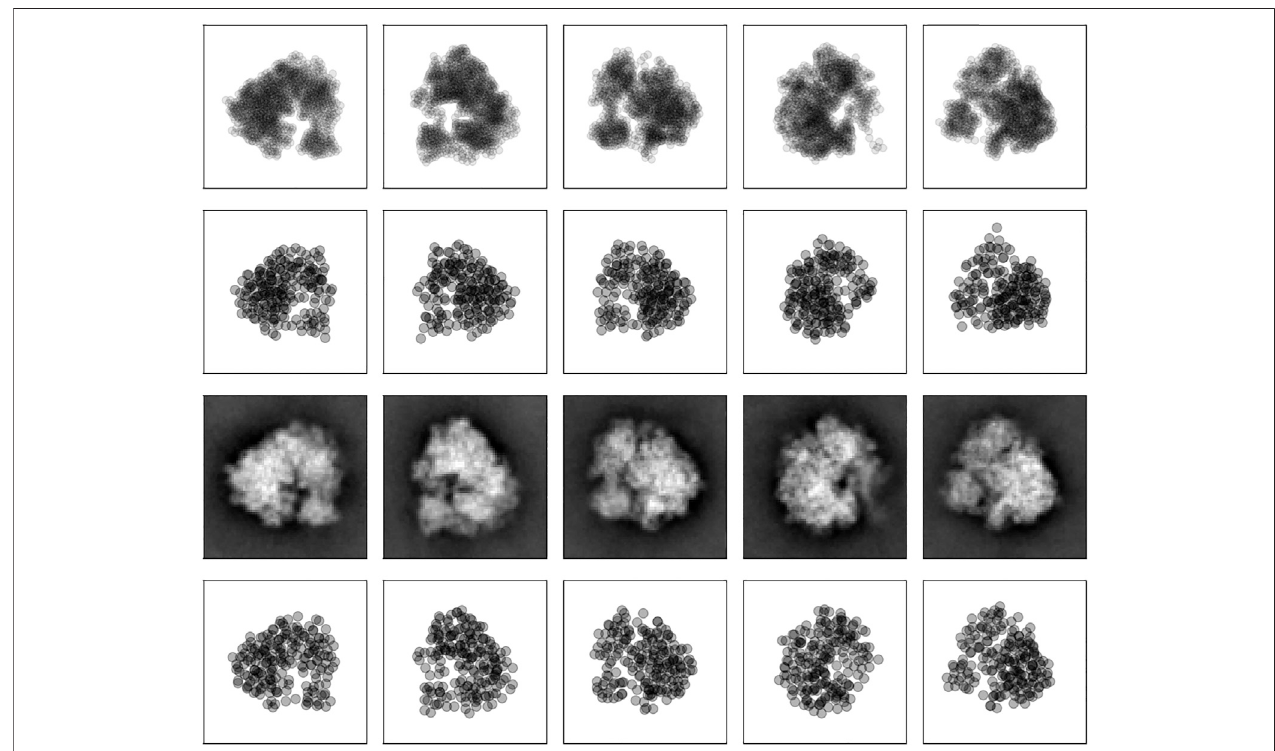
FIGURE5| 2Dprojectionsofthe80Sribosome.Firstrow:pointcloudsderivedfromclassaverages.Eachprojectionimageisrepresentedby1,000points.Second row: 2D projections of the coarse-grained model calculated with Bayesian random tomography based on 2D point clouds. Third row: Class averages. Bottom row: 2D projections of the coarse-grained model calculated with Bayesian random tomography based on class averages.